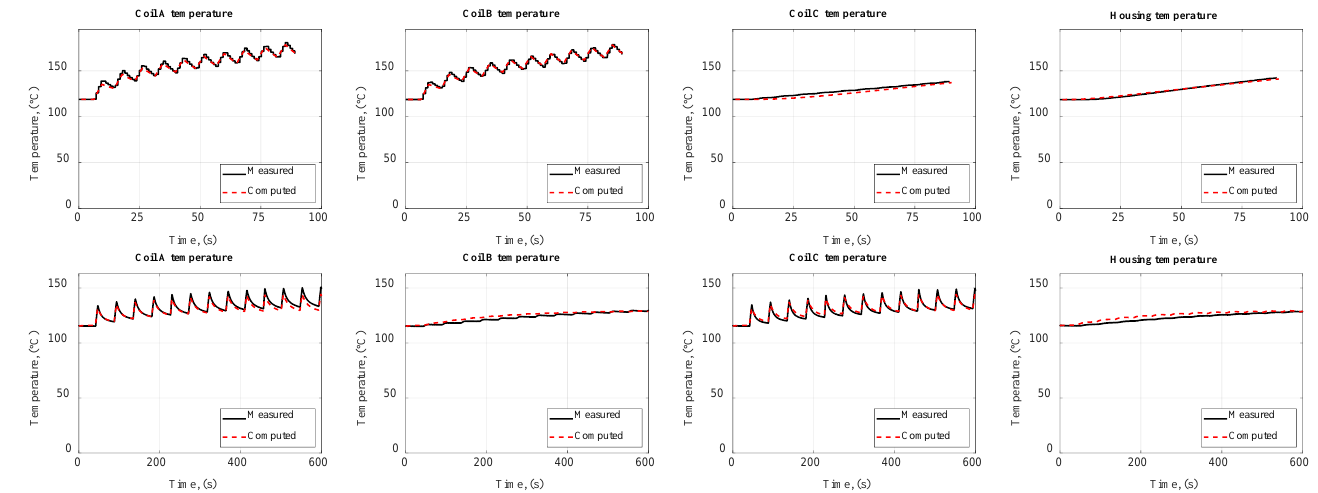
Figure 20. Measured and computed temperatures in the three phases (Coil A, B, C) and in the housing for both load cycle tests.